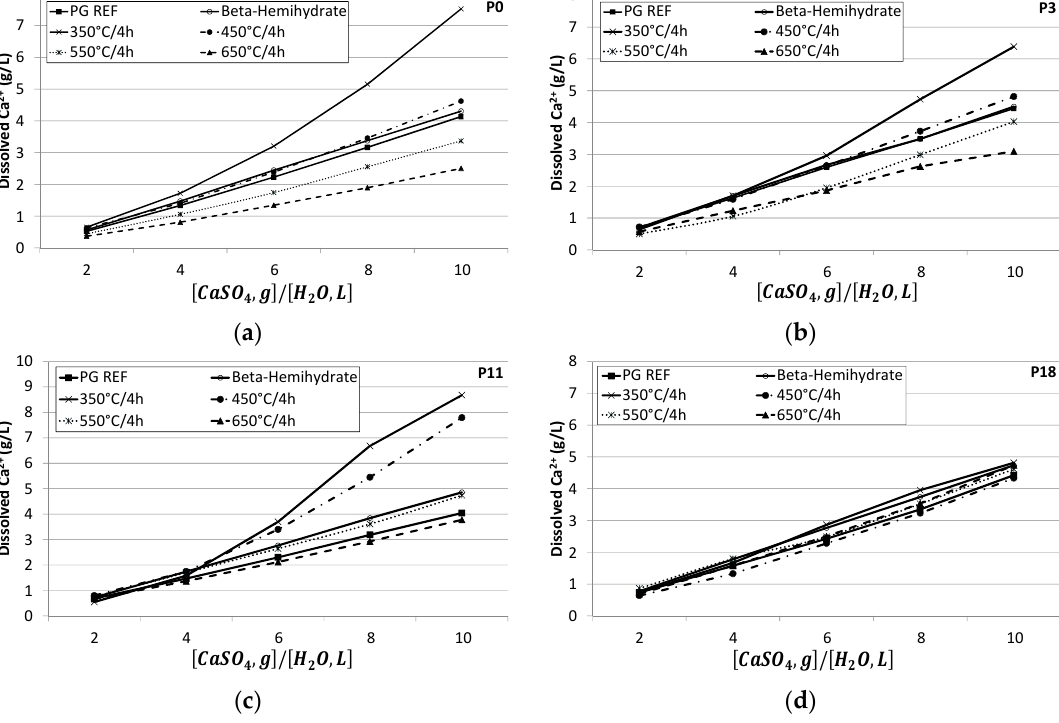
Figure 5. Solubility (g/L) over time. ( a ) Period = 0; ( b ) Period = 3 days; ( c ) Period = 11 days; ( d ) Period = 18 days.